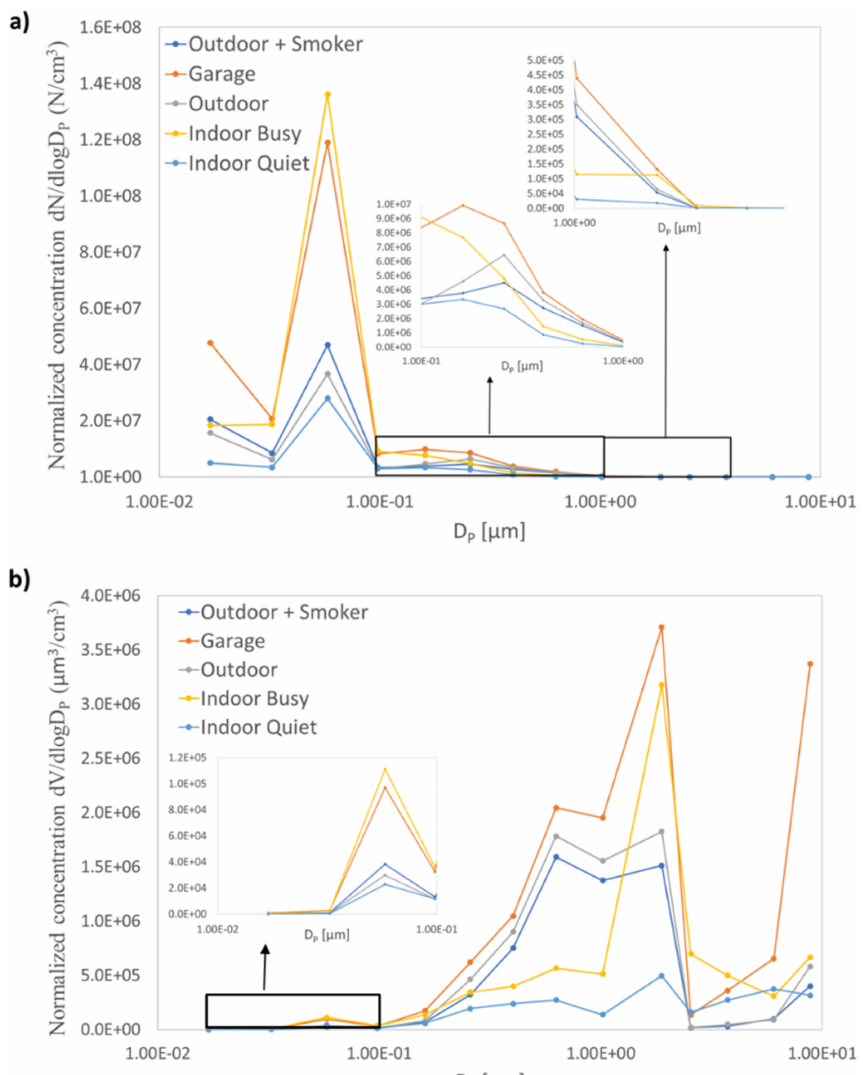
Figure 5. Size distribution curves of normalized particle concentrations in different environmental conditions reported in terms of ( a ) number and ( b ) volume of particles (ELPI+ data). Specific expansions of the curves are shown in the